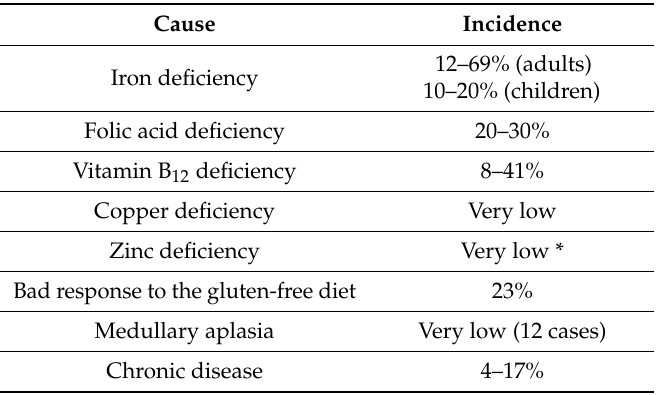
Table 1. Etiology of anemia in celiac